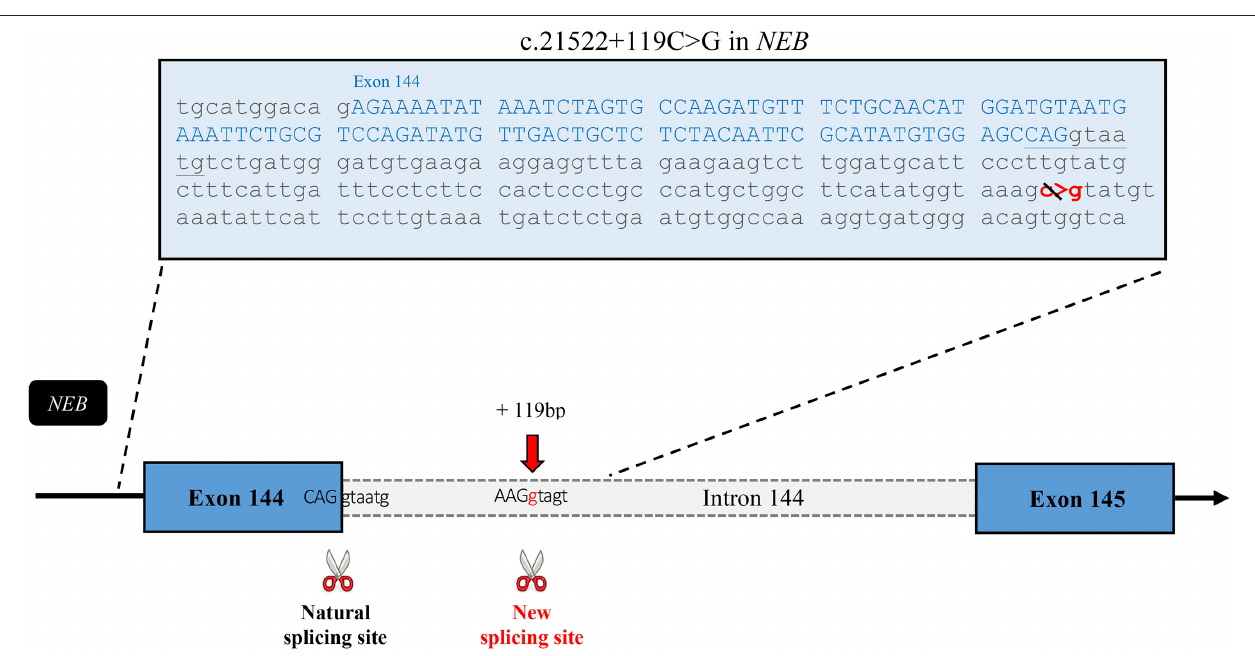
FIGURE 4 | In silico analysis of the effects of the mutation. Sequence of the exon 144 followed by the first part of the intronic sequence that includes the mutation. This schematic representation of the affected region of the nebulin gene shows the new splice site predicted to be created by this intronic variant. According to Human Splicing Finder, the new site has a strength of 90.24* in comparison with 85.75* for the natural site. *These numbers are relative consensus values established by the tool ranging from 1 to